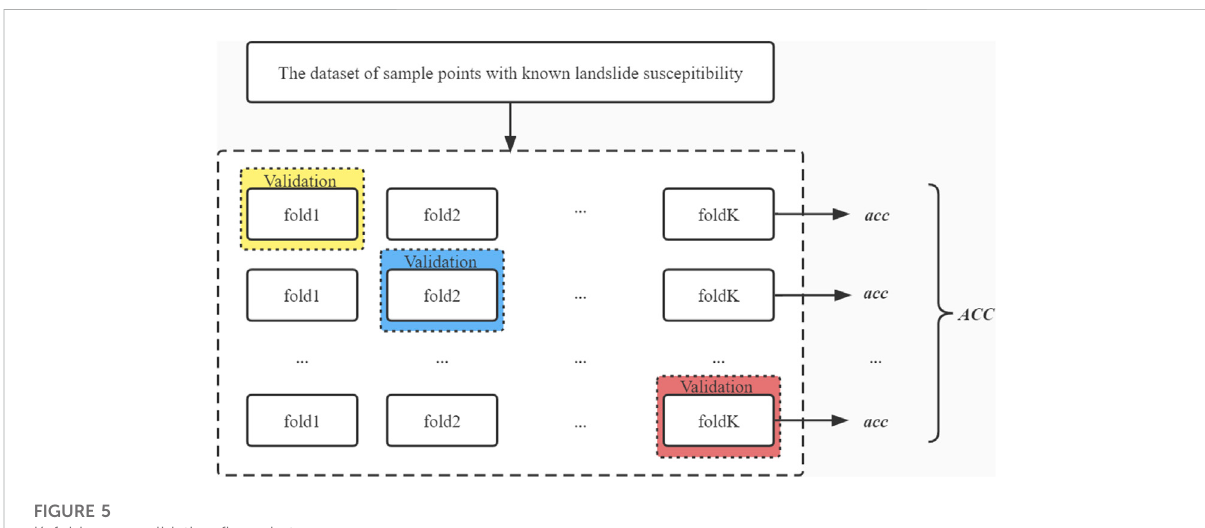
FIGURE 5 K-fold cross-validation fl ow